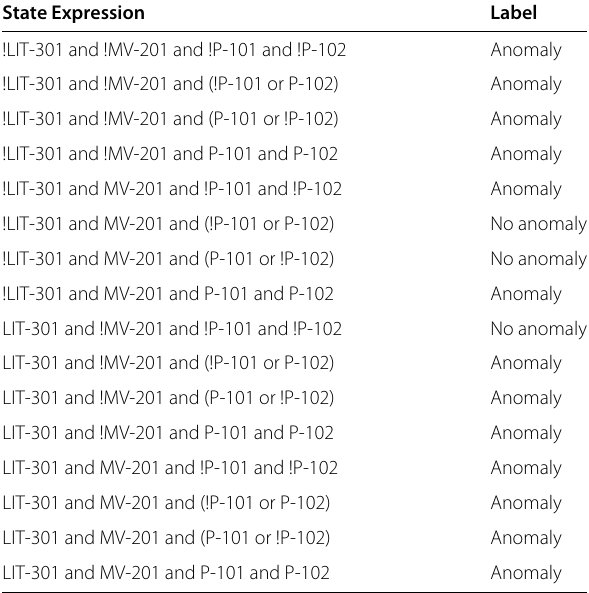
Table 8 State expressions of Invariant #3 for